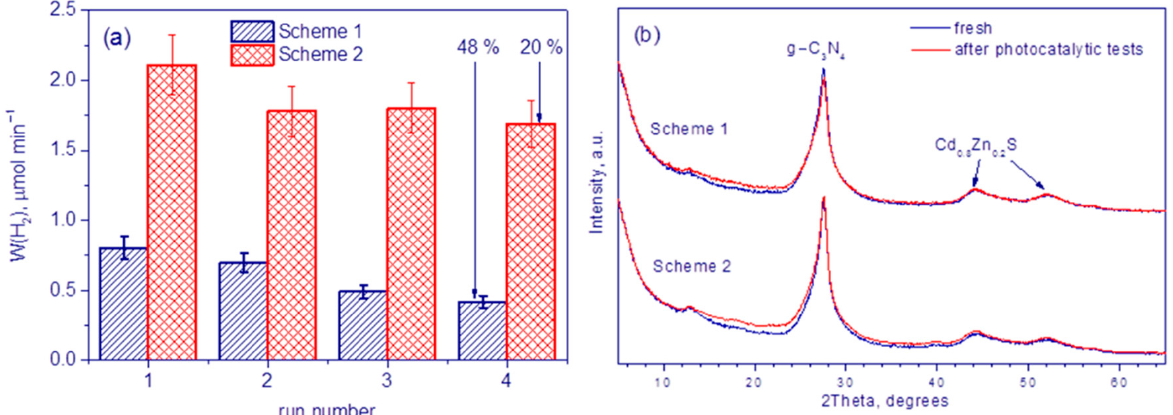
Figure 9. The activity of the photocatalysts Pt/20Cd0.8/CN and 20 Cd0.8/Pt/CN in four 1.5 h consecutive hydrogen evolu- tion runs ( a ) and XRD patterns of these samples before and after photocatalytic tests ( b ). Conditions: C 0 (NaOH) = 0.1 M, C 0 (TEOA) = 10 vol%, C cat = 0.5 g L − 1 ; LED light source ( λ = 450 nm).